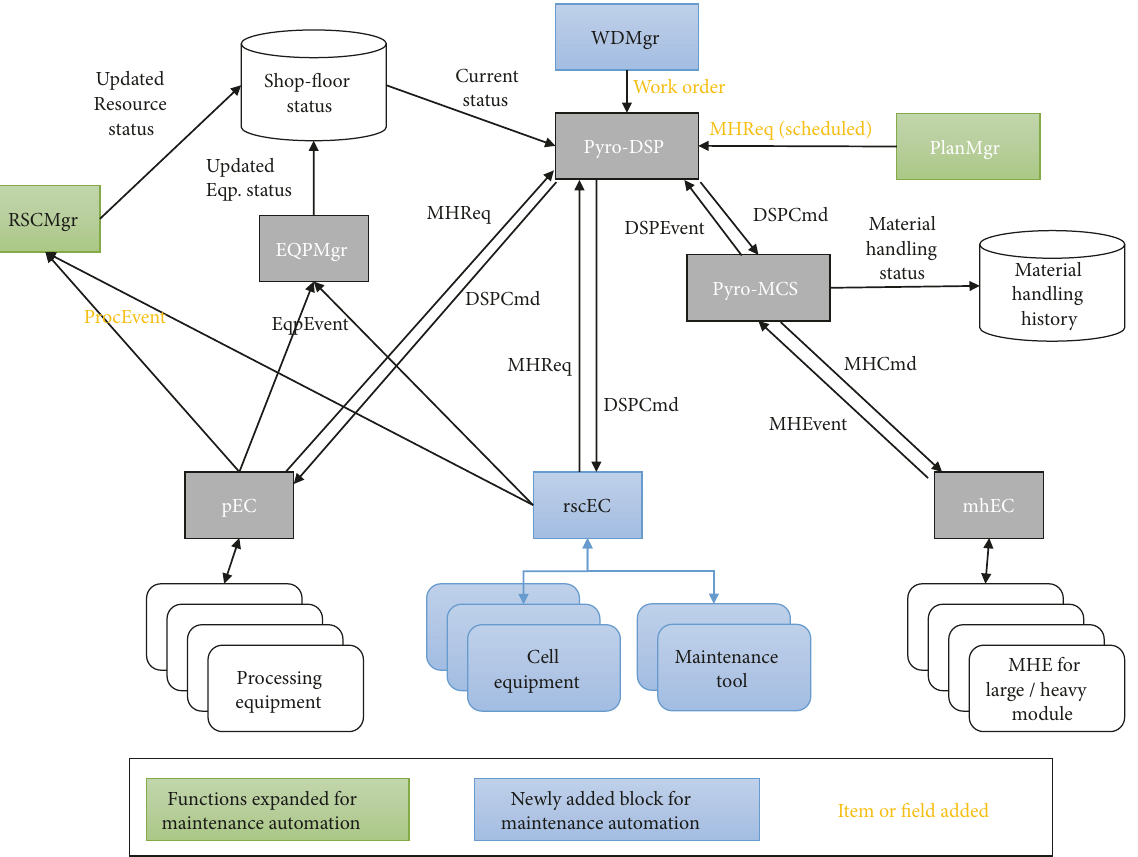
Figure 4: Upgraded PES functional architecture for maintenance operations.